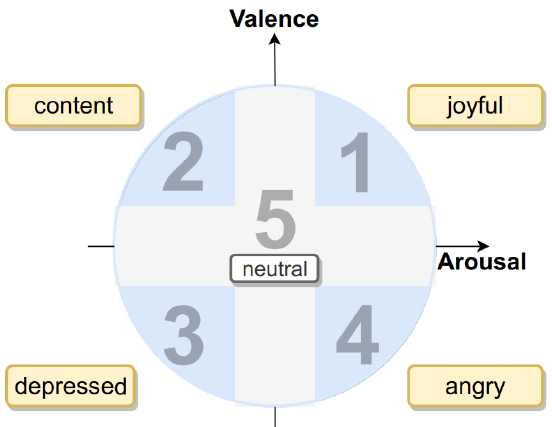
Figure 4. Graphical representation of the five-emotion mapping. Blue area represents four different emotion domains. Gray area corresponds to the neutral emotion.